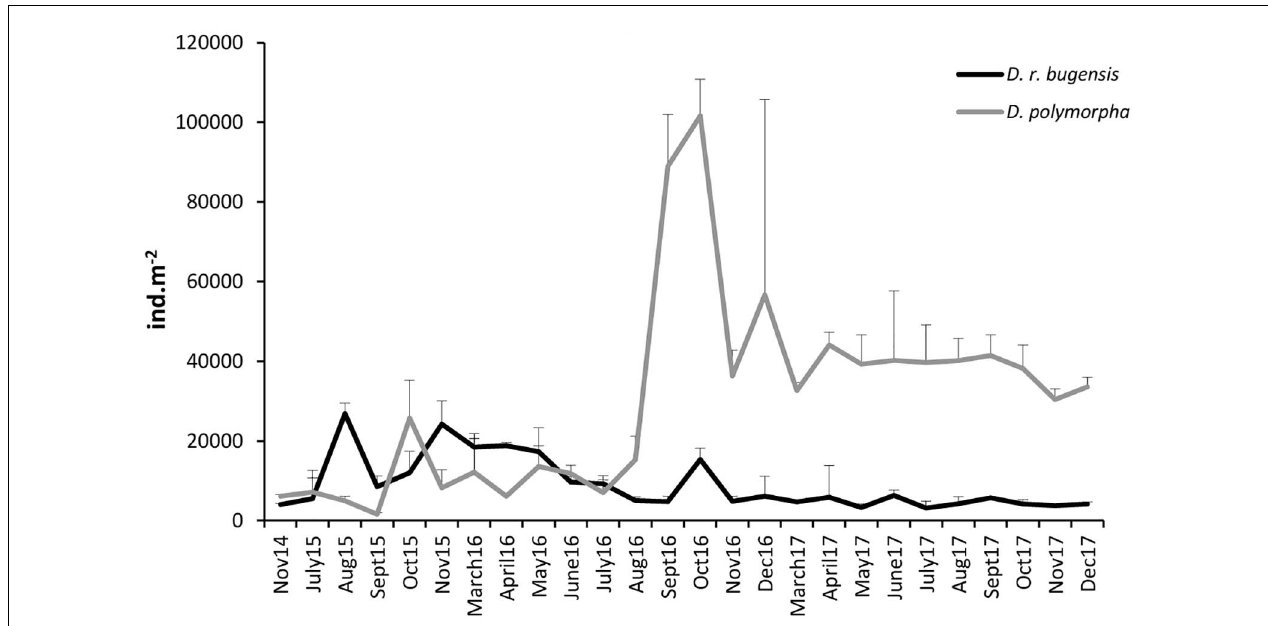
FIGURE 3 | Changes in mean abundances of D. polymorpha and D. r. bugensis in 2014–2017 at station ZS6; error bars denote standard deviations.